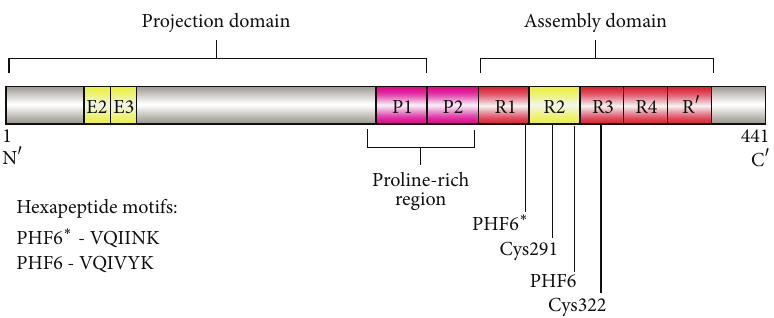
Figure 1: Tau protein structural features in linear diagram. A full-length tau protein with 441 amino acids (tau441 or tau 2N4R) is shown. Alternative splicing showed in yellow rectangles results in a total of six isoforms, denoted by either their total number of amino acids or the number of N 󸀠 -terminal exons (Ns) and microtubule-associated repeats (Rs).